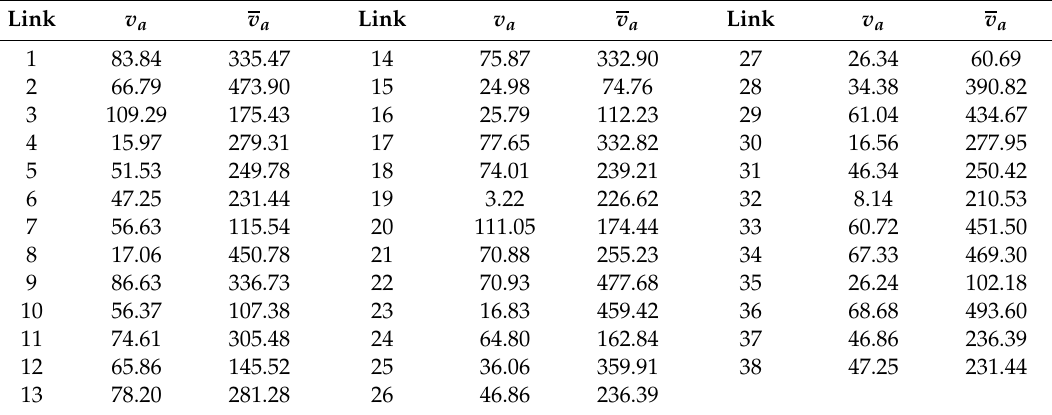
Table 8. Link flows of the NCP for the Nguyen–Dupuis network.